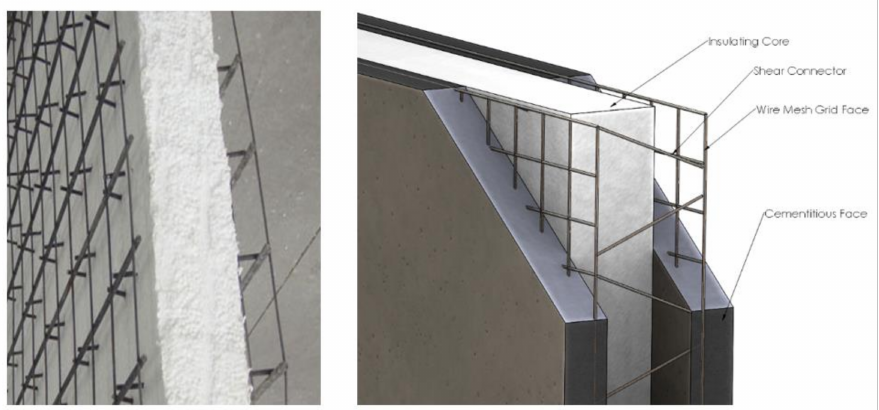
Figure 3. Details of a typical cementitious sandwich panel with individual welded wire shear connectors ( Class I